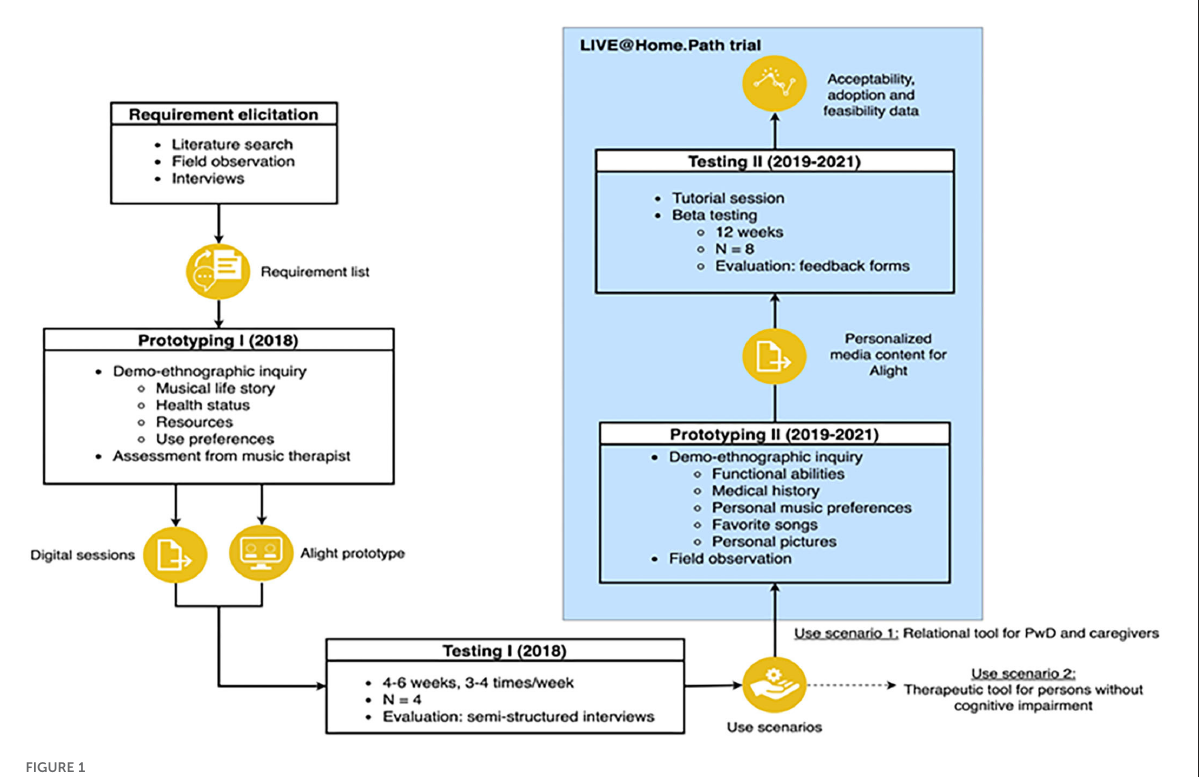
FIGURE1 The iterative participatory design process of the Alight